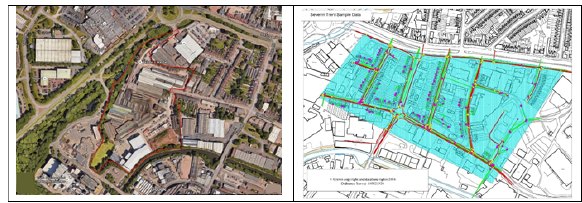
Figure 8: The municipality of Birmingham pilot